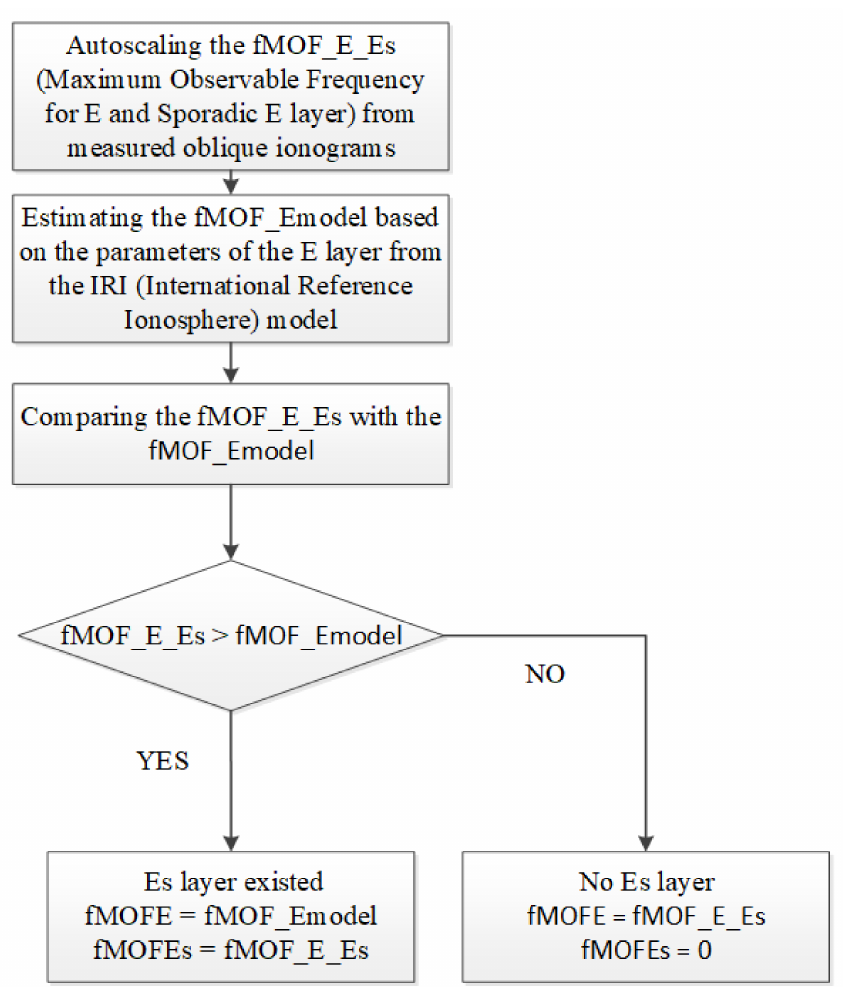
Figure 3. Flowchart of estimating the parameters of E and Es layer from measured oblique